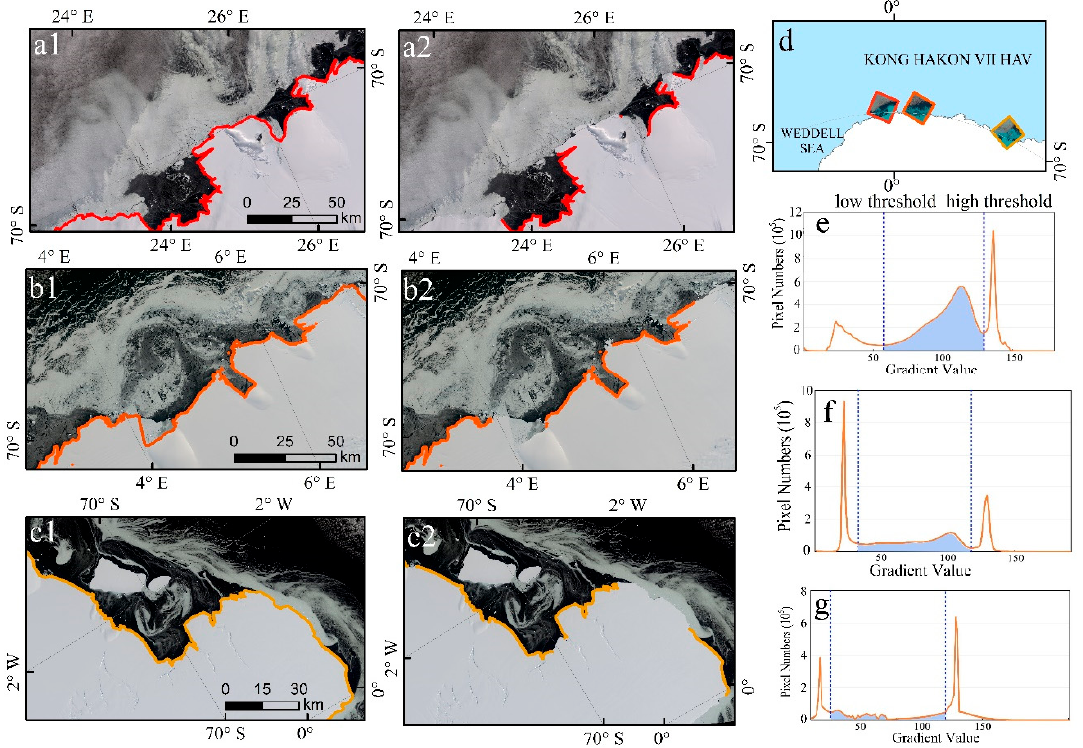
Figure 2. Three pairs of Landsat-8 false color images (locations identified in ( d )) are shown in ( a1 , a2 ), ( b1 , b2 ), and ( c1 , c2 ). Histograms of the pixel gradients are shown in ( e – g ), respectively. The two thresholds are marked by the blue-dashed lined in each histogram, while the blue gap between the two lines represents the gradient range for the potential edge points. Coastline extraction results using two thresholds and one threshold (the maximum threshold) are overlaid on the Landsat-8 images in the left and middle panels, respectively. The color composition we use is from bands 1, 2, and 3.